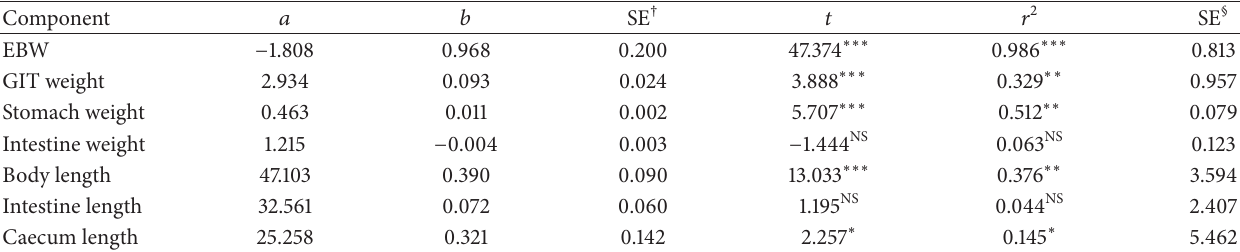
Table 3: Estimated parameters for the regression equations of the empty body weight (EBW), whole gastrointestinal tract (GIT), and some segments of GIT and bivariate correlations displaying the relationship among these variables and slaughter weight. Component 𝑎